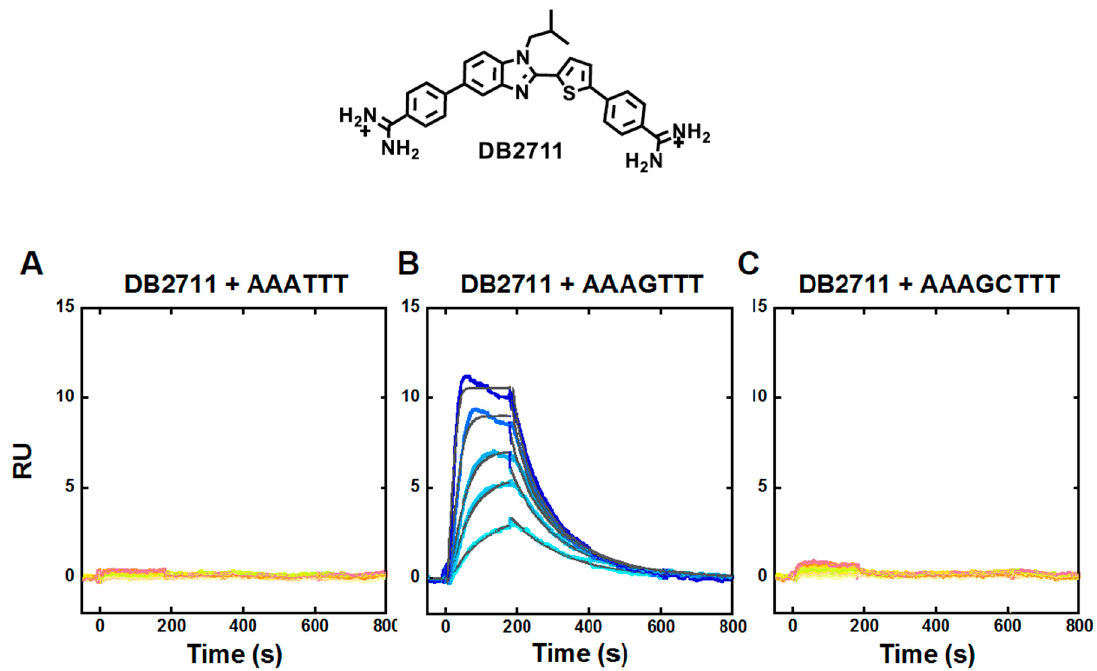
Figure 5. Representative SPR sensorgrams for DB2711 in the presence of ( A ) AAATTT, ( B ) AAAGTTT and ( C ) AAAGCTTT hairpin DNAs. In A, C, the concentrations in the sensorgrams are 2–100 nM of each compound from bottom to top. In B, the concentrations of DB2711 from bottom to top are 15, 30, 40, 70, and 100 nM; In B, the solid black lines are best-fit values for global kinetic fitting of the results with a single site function.